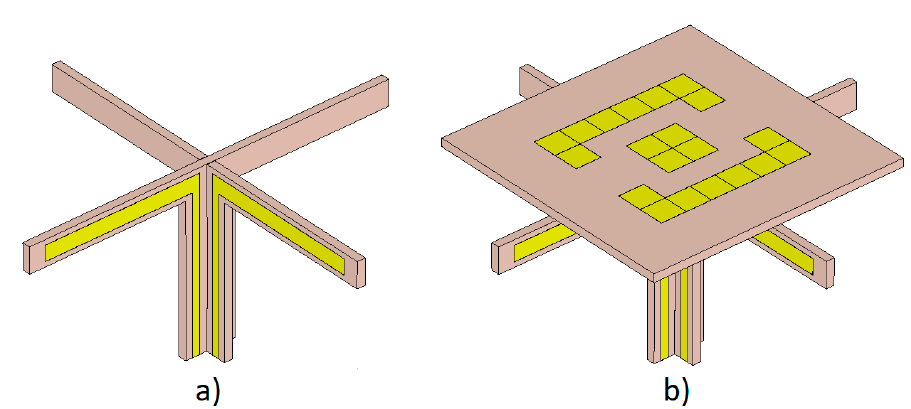
Figure 7. Cross dipole antenna ( a ) with a resonator plane and ( b ) without a resonator plane.